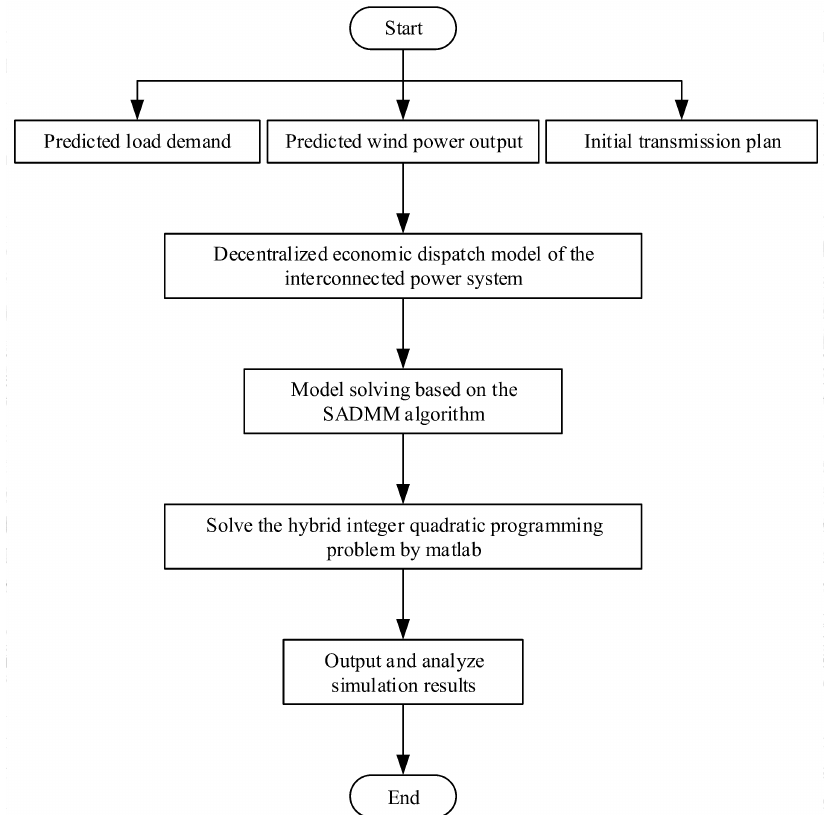
Figure 2. Integrated schematic of the whole